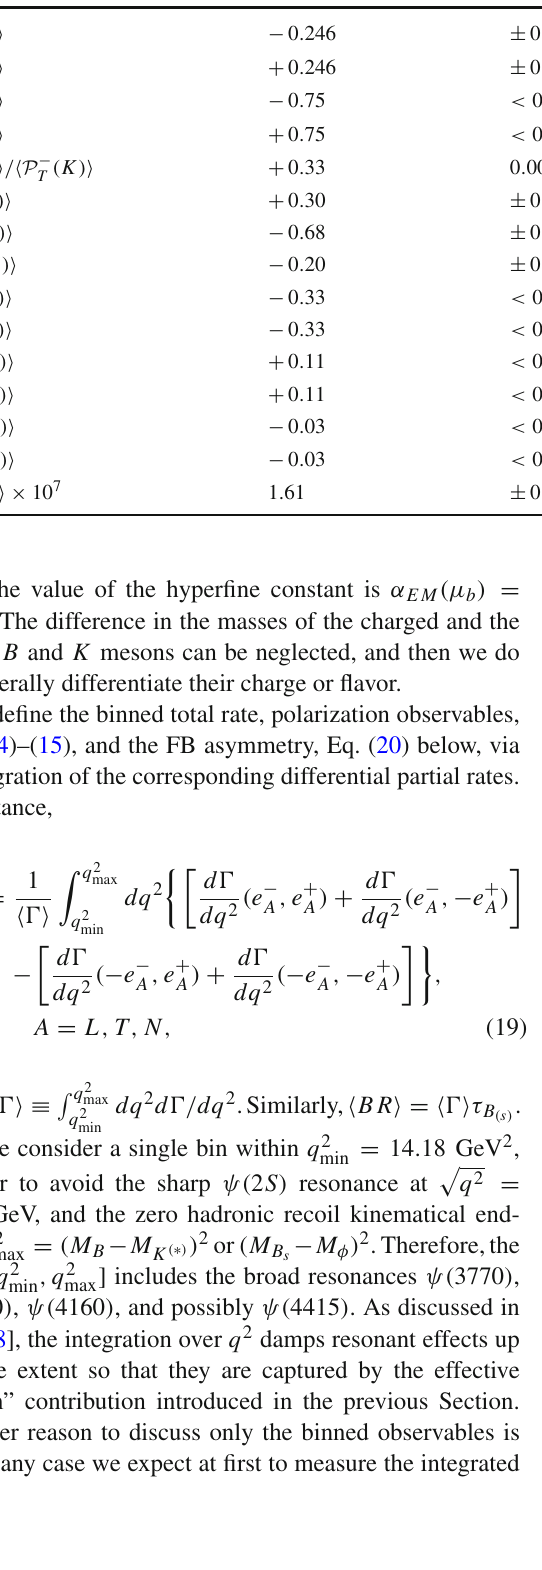
Table 2 SM predictions for B − → K − τ + τ − observables. The first uncertainties correspond to the quadratic sum of the effects of the variations of the form factor uncertainties over their quoted intervals (after diagonalization to take into account the quoted correlations). The “Charm”uncertaintiescorrespondtocorrectionsof10% × C eff Asyms.,